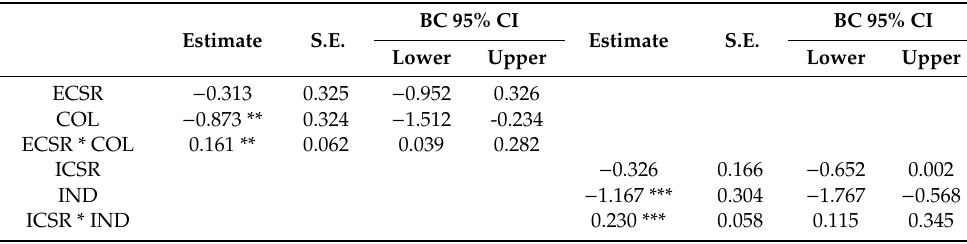
Table 4. Moderating analysis results.